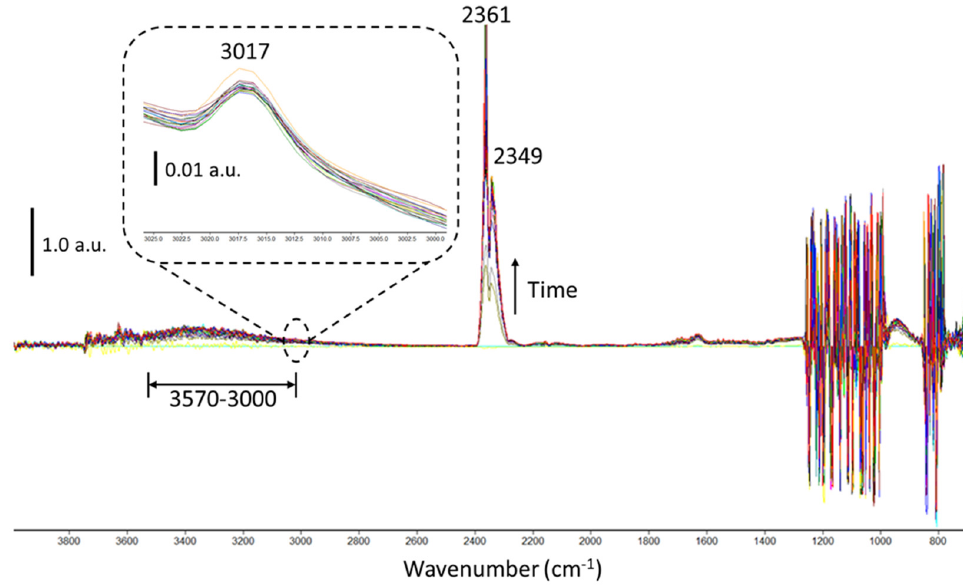
Figure 6. FTIR subtraction spectra acquired as a function of time up to steady state after plasma ignition in CO 2 methanation conditions on 3Ru/CsUSY, with magnification of the 3025–3000 cm − 1 region. In Figure 7, a magnification of the FTIR difference spectra seen in Figure 6 in the 2400–1250 cm − 1 region is shown.